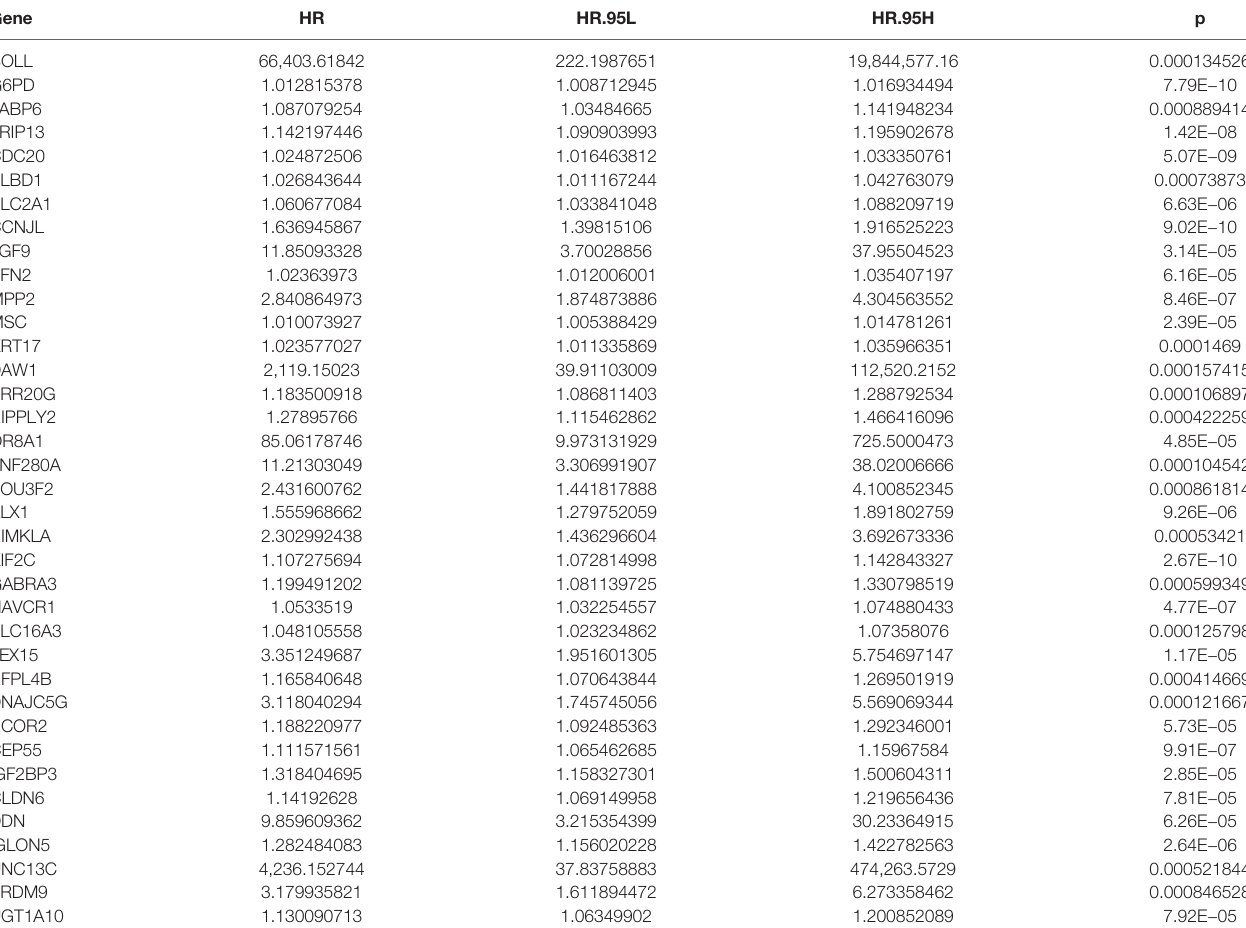
TABLE 3 | Association of the 37 cluster-related DEGs with the prognosis of HCC